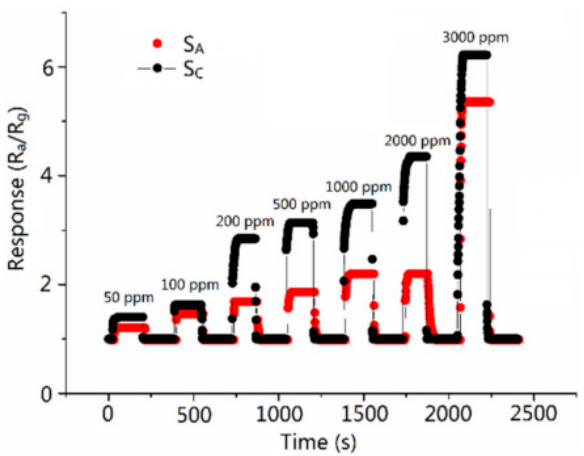
Figure 11. Responses to 50–3000 ppm of CO gas of imprinted (S C ) and nonimprinted (S A ) sensors at 300 °C [52].